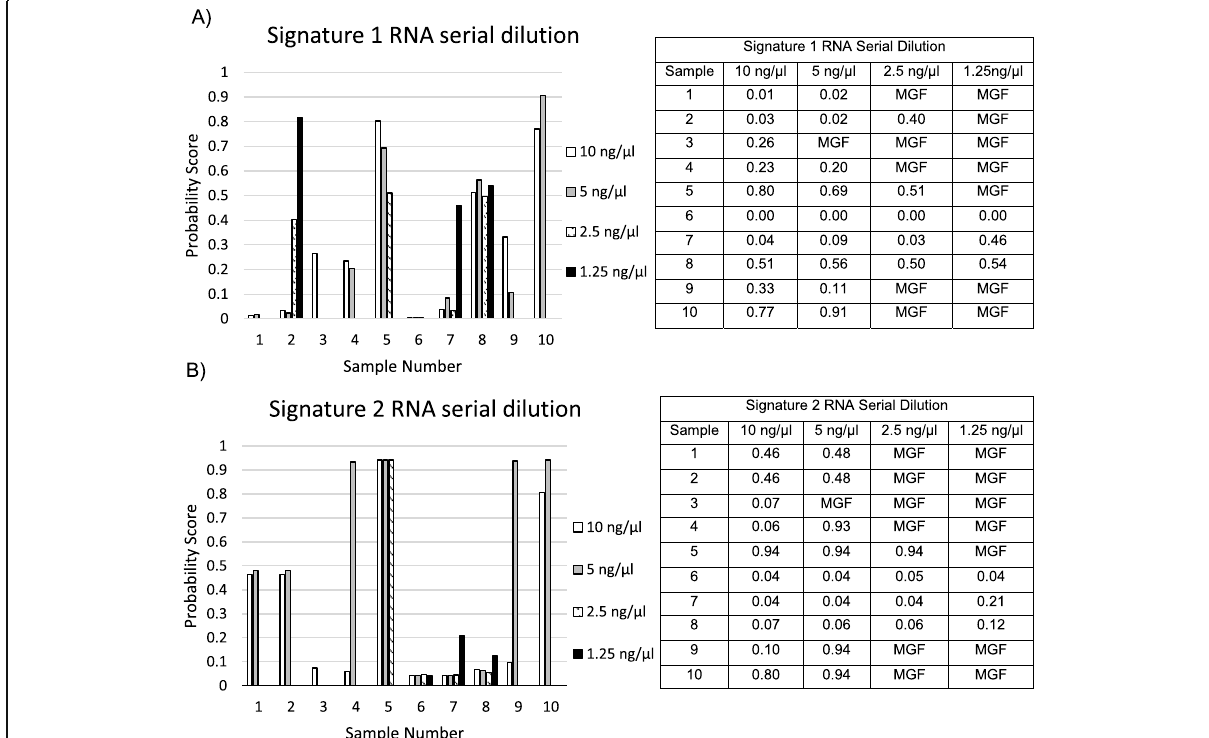
Fig. 2 Determination of input RNA concentration using a serial dilution from 10 to 1.25 ng/ μ l, the probability scores of both A) Signature 1 and B) Signature 2 are shown for 10 FFPE samples. MGF-multiple gene